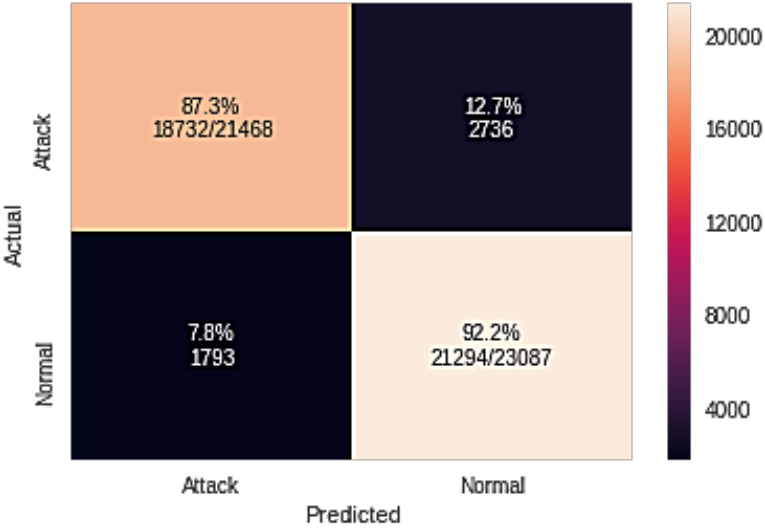
Figure 25. Logistic regression binary class confusion matrix.